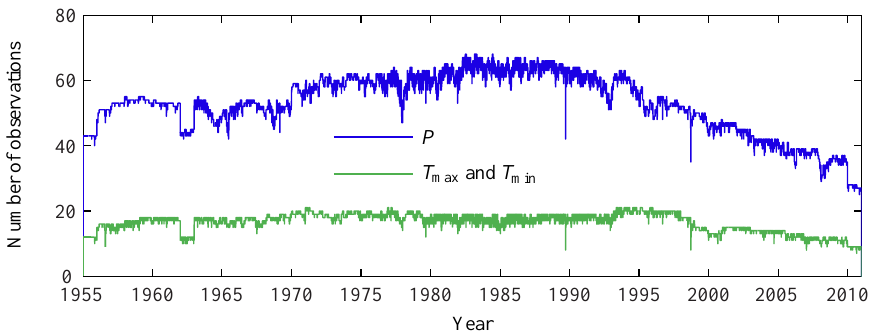
Fig. 2. Graph showing the number of daily observations for P , T max , and T min . Only stations with records > 20yr were used. The x-axis marks 1 January of each fifth